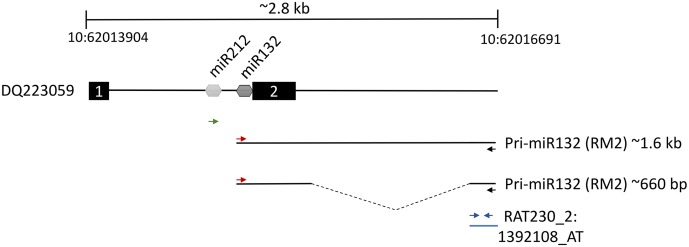
Two thousand eight hundred base pair region of rat chromosome 10 between nucleotides 62013904 and 62016691 containing the pri-miR132/RM2 gene loci. Dq223059 transcript contains both miR212 and miR132 between putative exon 1 and exon 2. We discovered a ∼1.6 kb and a ∼660 bp transcript that was present within ML samples that were collected 4 h post-pp-HFS. These transcripts contained the miR132 coding sequences to be contiguous with RNA sequences represented by the Affymetrix RM2 probe, RAT230_2:1392108_AT. The red and black arrows indicate the positions of the forward and reverse PCR primers, respectively, used to amplify the ∼1.6 kb and ∼660 bp transcripts. The green arrow represents the forward PCR primer intended to amplify the miR212 sequence when coupled with the RM2 reverse primer (black arrow); however, this primer pair did not yield a PCR product. Blue arrows indicate the locations of the PCR primers used for qRT-PCR of the pri-miR132/RM2 transcript. Dotted line within the ∼660 bp transcript indicates the location of a likely intron.